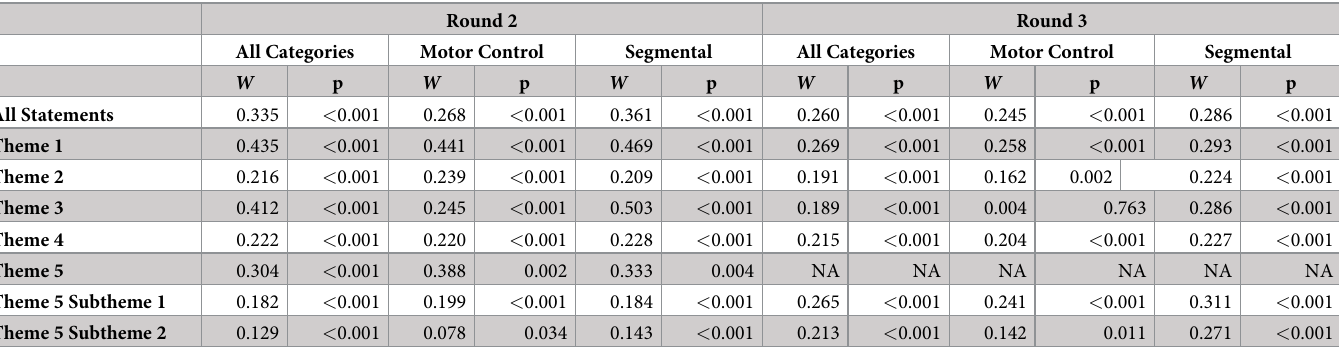
Table 3. Inter-expert agreement using Kendall’s Coefficient of